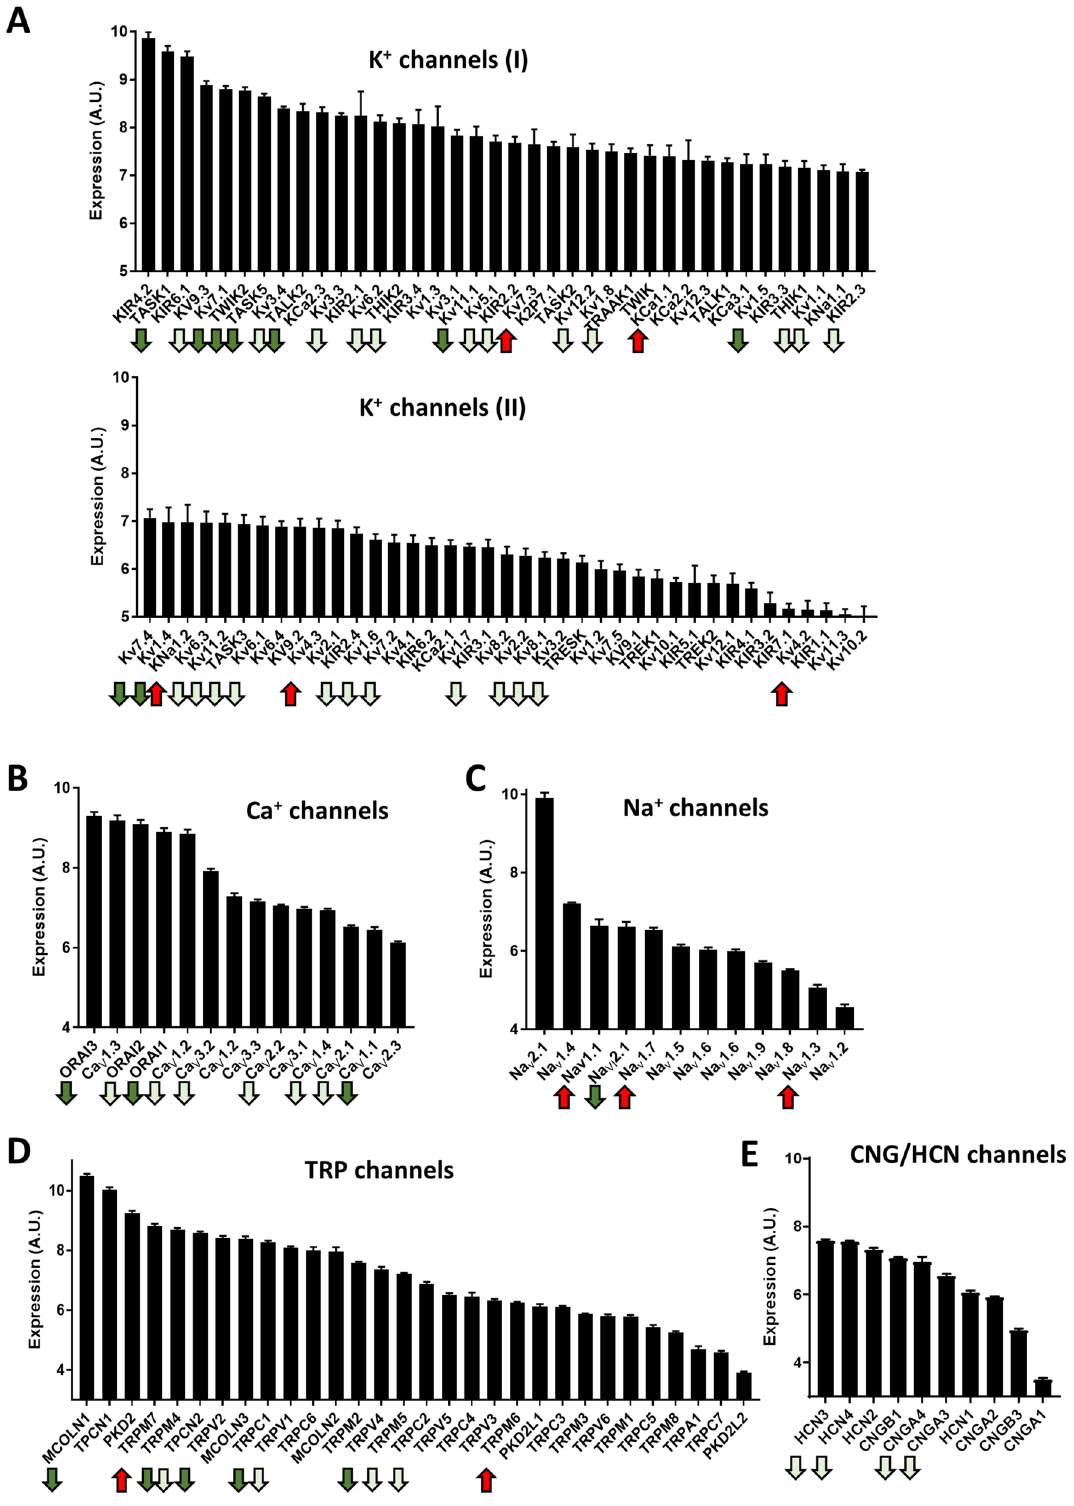
Figure 2. Relative abundance of ion channel encoding genes in the control lungs. Bars represent means ± SEM (n = 10). Arrows indicate significantly (adjusted p < 0.05) dysregulated channels in PAH: dark green for > twofold downregulation, light green for < twofold downregulation and red for > twofold